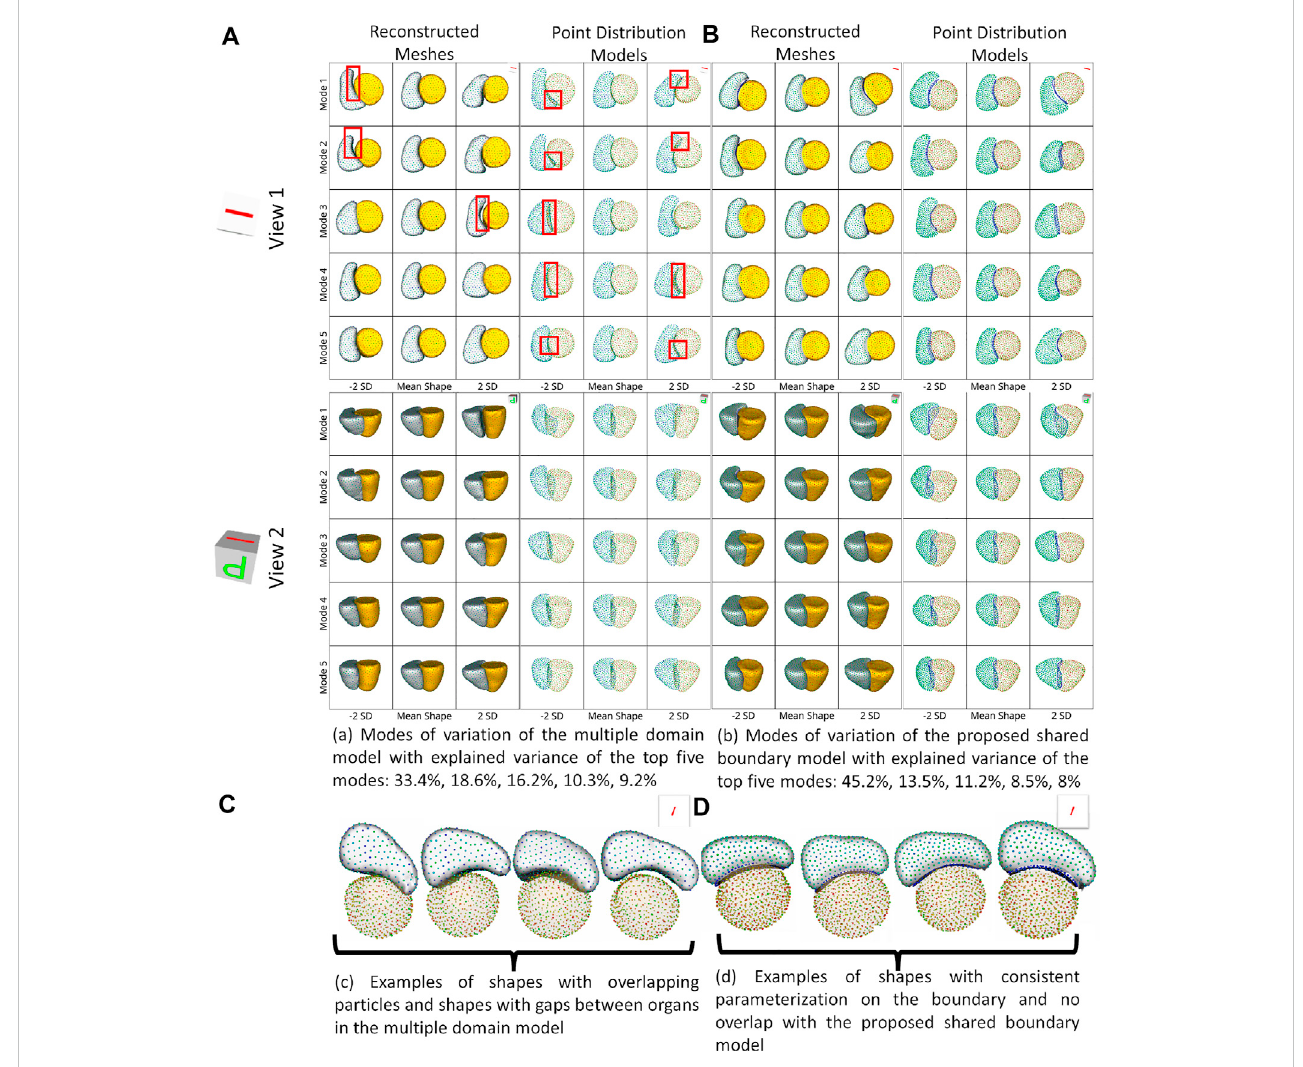
FIGURE 5 Two different views of the same reconstructed meshes and the point distribution models of the modes of variations discovered by (A) multiple domains modeland (B) theproposedsharedboundarymodel. Theredboxesindicateshapemodeling inconsistencies ofmultipledomain model-particleoverlapand gaps between organs. (C) Examples of shapes with overlapping particles and shapes with gaps between organs in the multiple domains model and (D) examples of shapes with consistent parameterization in the proposed shared boundary